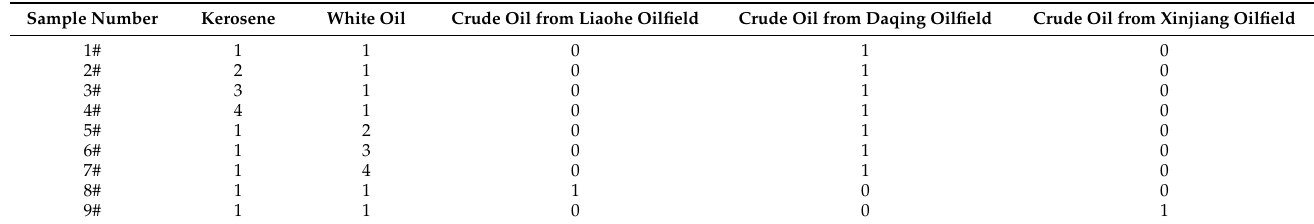
Table 2. Volume ratio of different types of oil phase in simulated